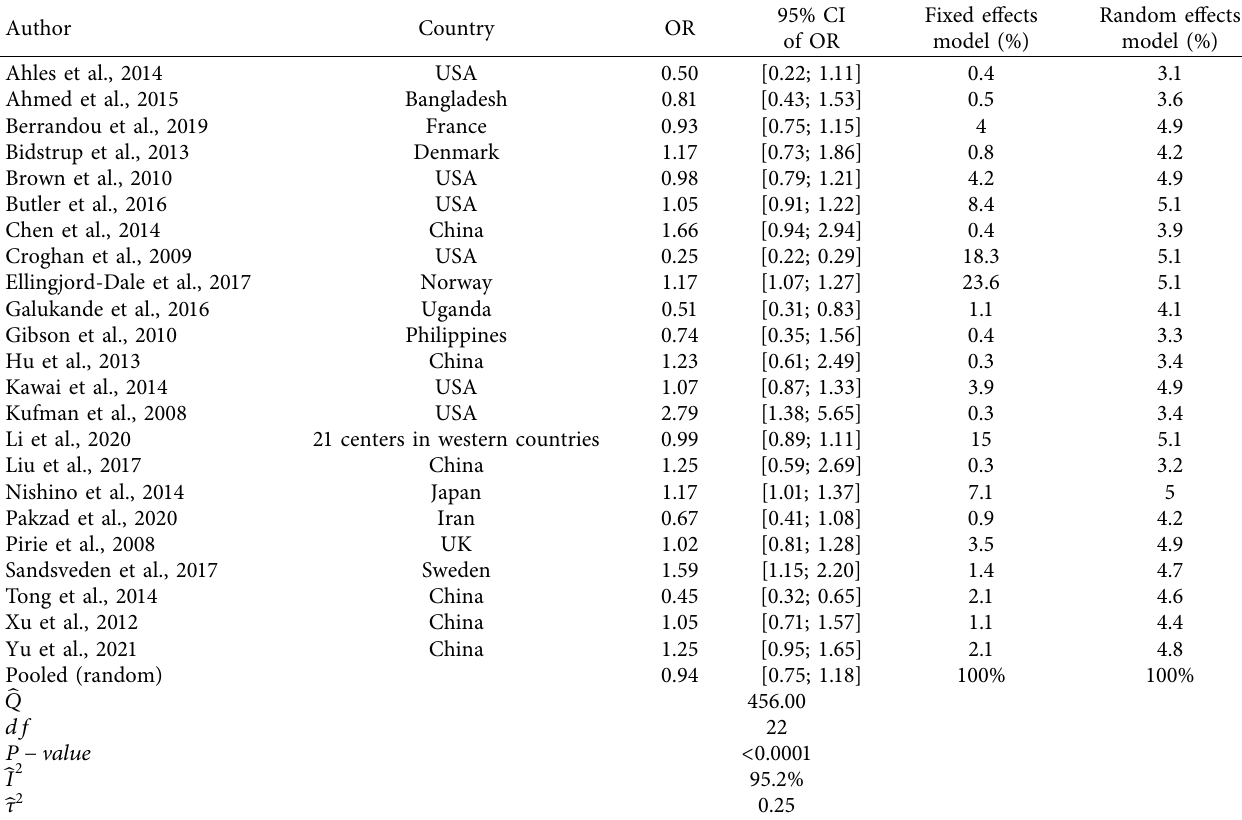
Table 2: Summary of the random efects and fxed efects models for alcohol consumption.